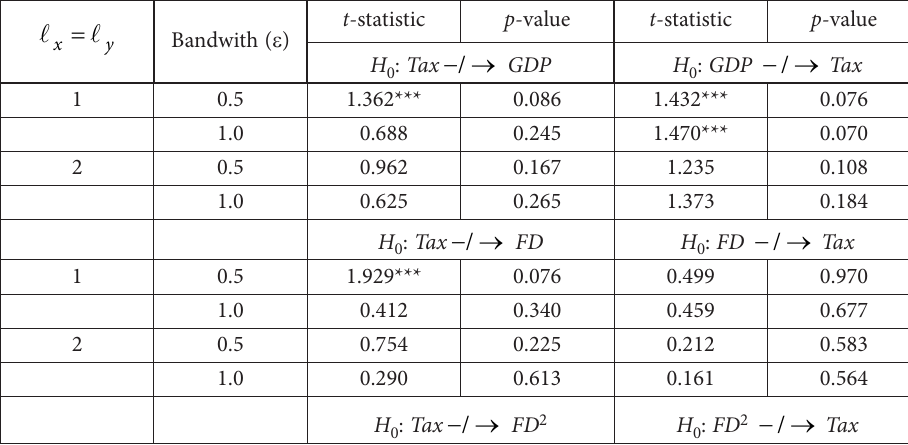
Table 14. Nonlinear causality